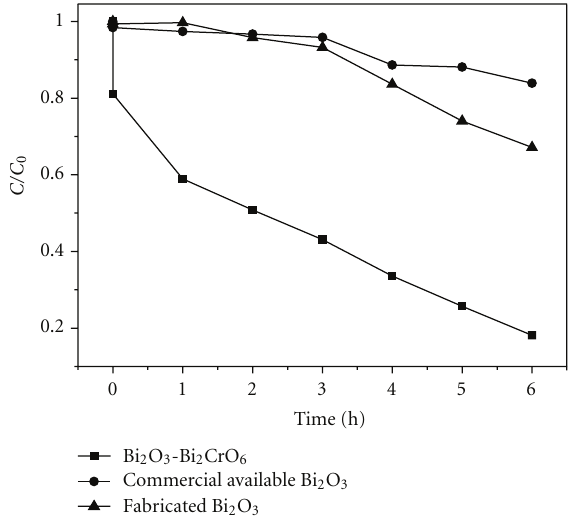
Figure 7: XRD pattern of the sample synthesized in di ff erent pH value of starting solution: (a) pH = 1; (b) pH = 2; (c) pH = 3; (d) pH = 4; (e) pH = 5; (f) pH = 6; (g) pH = 7; (h) pH =